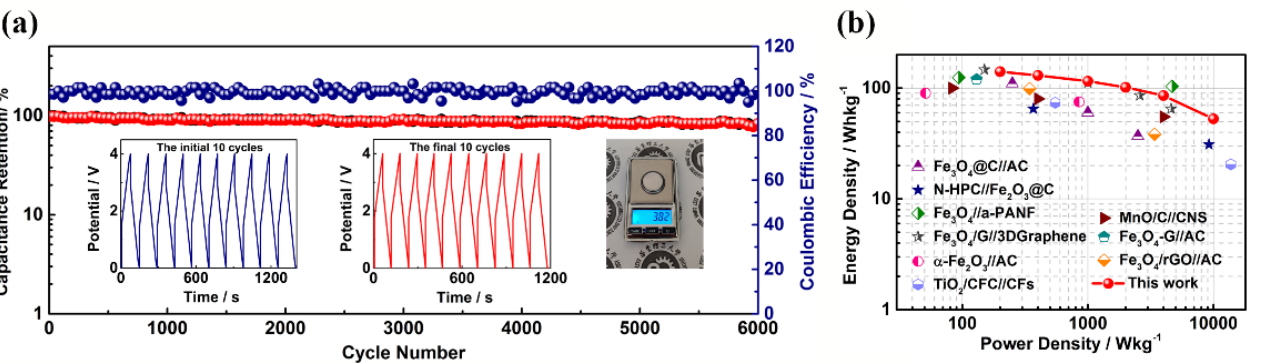
Figure 7. ( a ) CV curves of Fe 3 O 4 @C//AC LIC at 2–10 mV s − 1 , ( b ) GCD profiles of Fe 3 O 4 @C//AC LIC at 0.1–1 A g − 1 .